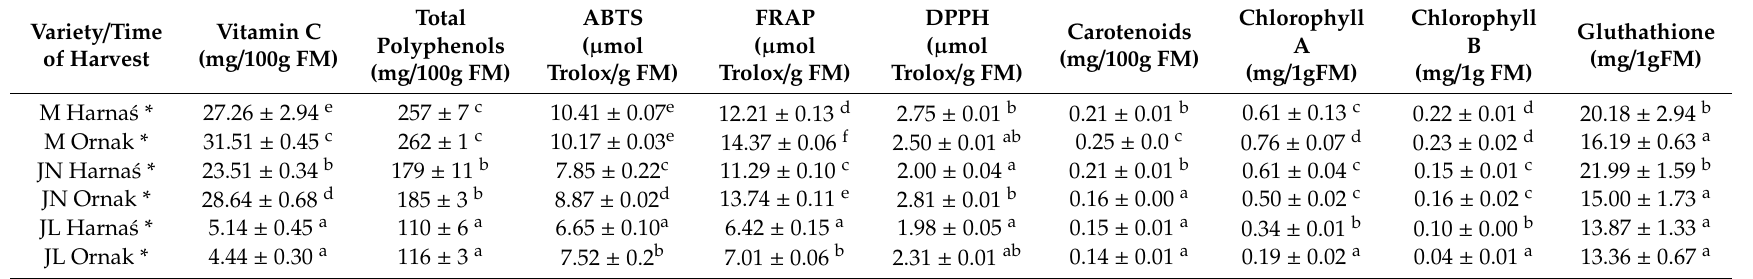
Table 2. Bioactive compounds content in whole plants of garlic cultivated from air bulbils (g / 100 g FM # ). Variety /